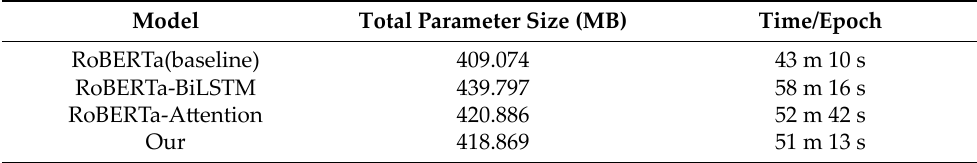
Table 8. Comparison of parameter size and running time.